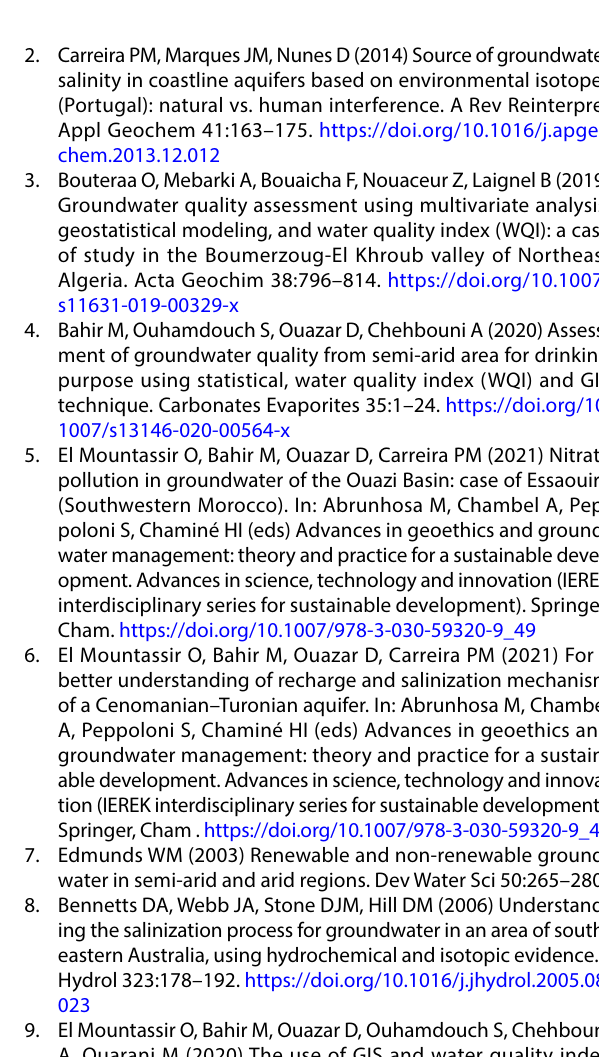
Fig. 9 Isotopic data in the study area. a δ 18 O versus δ 2 H for 2016 campaign; b δ 18 O versus Cl −